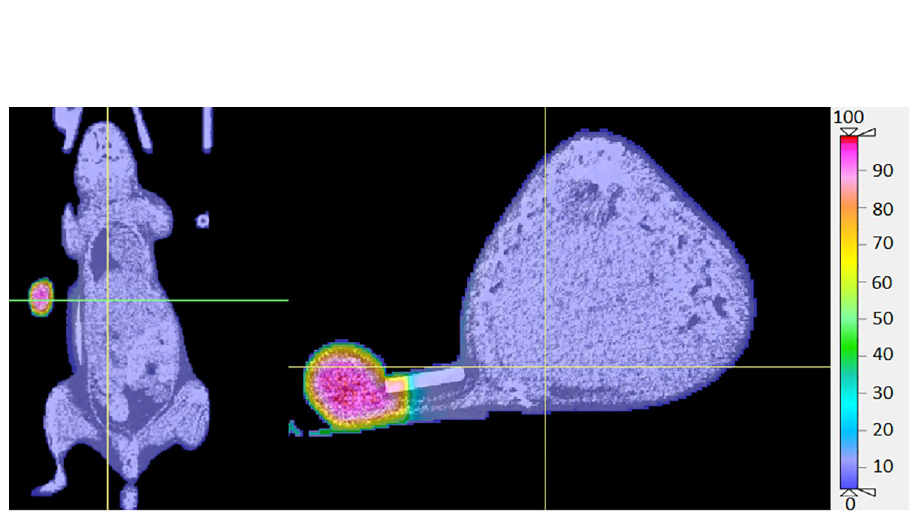
Fig 6. Dose distribution colourwash demonstration on micro-CT images in CERR. Doses are normalized to D max . The rubber band squeezes the mouse body out of the field and the accurate irradiation modelling of the tumour is demonstrated. The dose colourwash shows approximately 60%-100% of D max to the whole tumour and maximum 7% of D max to the normal